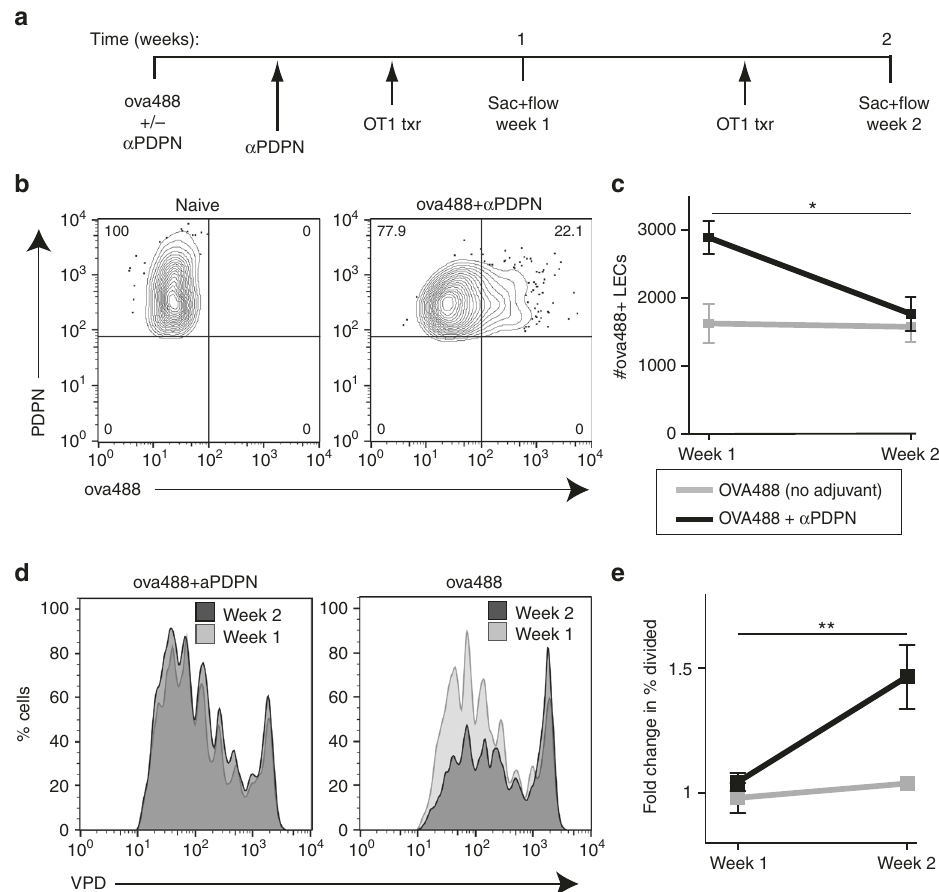
Fig. 8 Loss of antigen-bearing LECs results in antigen presentation. a Experimental design using anti- PDPN to expand lymphatic endothelial cells. b Wild- type mice were immunized subcutaneously with fl uorescent antigen (10 μ g/site) along, or in combination with two doses of the anti-PDPN antibody (100 μ g iv). One week after injection, mice were killed and the presence of antigen was visualized by fl ow cytometry. c Antigen + lymphatic endothelial cells were quanti fi ed at 1 and 2 weeks after antigen and PDPN treatment as in a . Mice of each treatment were pooled from two independent experiments with three mice per group per time point, where error bars represent the mean ± standard error of the mean. Statistical analysis was done using two-way ANOVA with a p -value of 0.0123 represented using one asterisk. d OT1 T cells were transferred 3 days before killing at 1 and 2 weeks, and e their percent division was calculated and normalized to 1 in order to visualize differences between weeks rather than due to an effect on T-cell division caused by PDPN treatment. Mice of each treatment were pooled from two independent experiments with three mice per group per time point. Statistical analysis was done using two-way ANOVA with a p -value of 0.0031 represented using two asterisks in e T-cell division in antigen alone (gray shaded) and antigen with PDPN treatment (black line) 2 weeks post injection of antigen. Error bars shown in the fi gure are mean and standard error of the